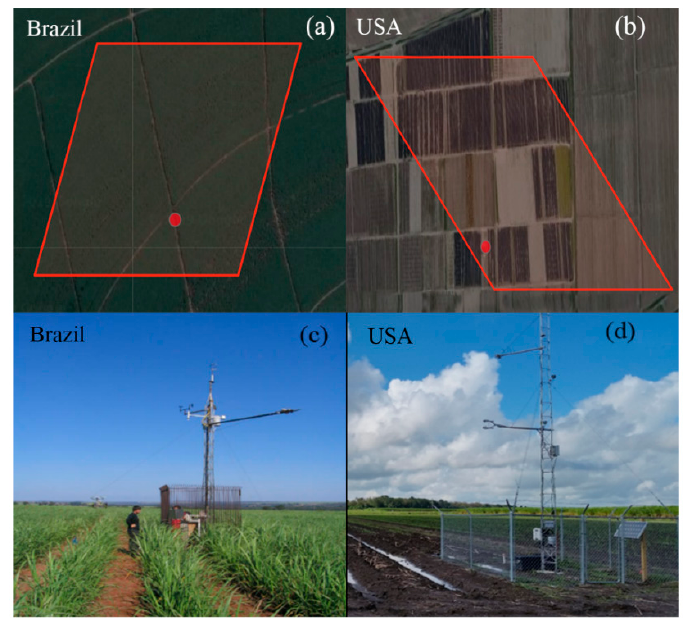
Figure 1. The longitude and latitude position information of the two sugarcane eddy covariance (EC) flux tower sites (red dot) and surrounding landscapes with one respective 500 m Moderate Resolution Imaging Spectroradiometer (MODIS) pixel (red polygon). ( a , c ), the USR site, Brazil; ( b , d ), the Louisiana site, USA.